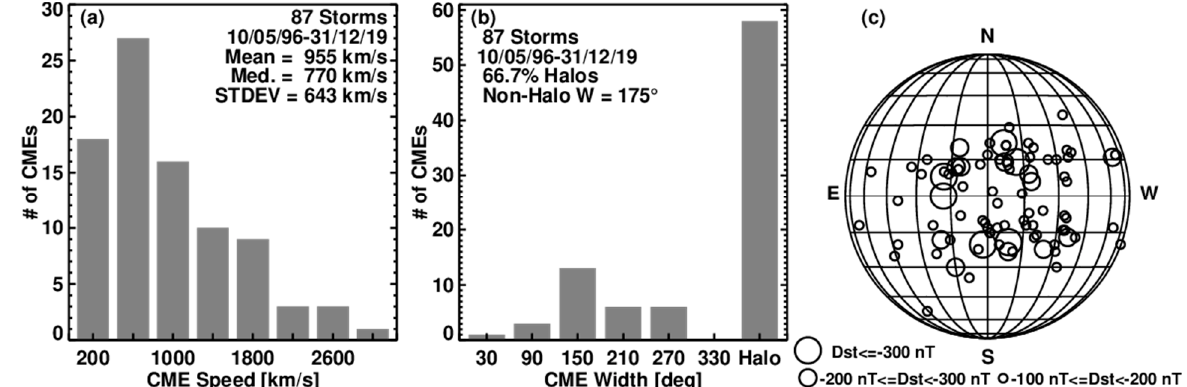
Figure 13. # means Number in Figure 13a,b. Distributions of speed ( a ), width ( b ), and source locations ( c ) of CMEs that resulted in intense geomagnetic storms (Dst ≤ − 100 nT), observed over a period of ~23 years. In ( c ) three storm intensity levels are distinguished by the size of circles. Geoeffective CMEs are fast and wide, and they originate from close to the solar disk center.